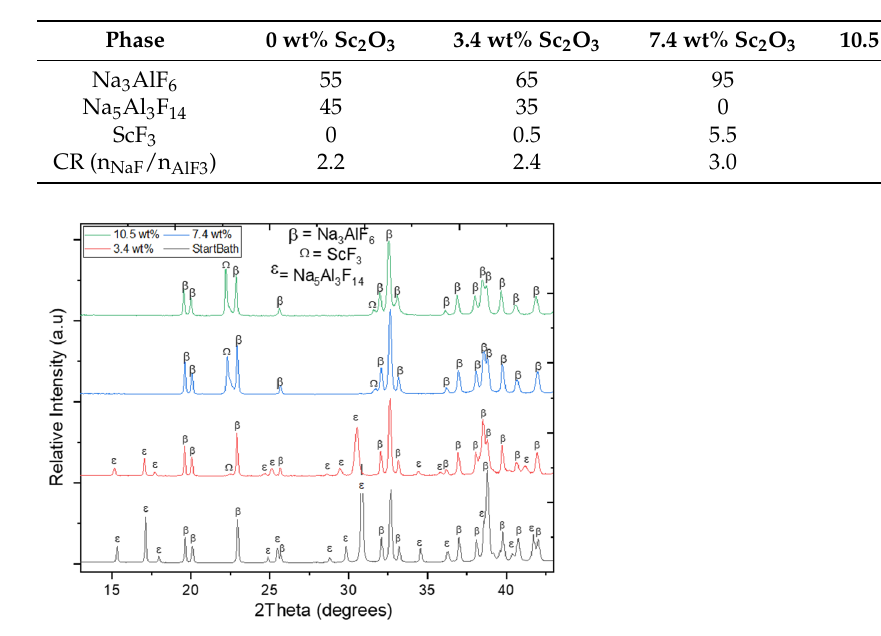
Figure 1. XRD diffractograms of bath samples taken upon Sc 2 O 3 additions to the molten cryolite. wt% of Sc 2 O 3 added prior to sampling are indicated in the insert.